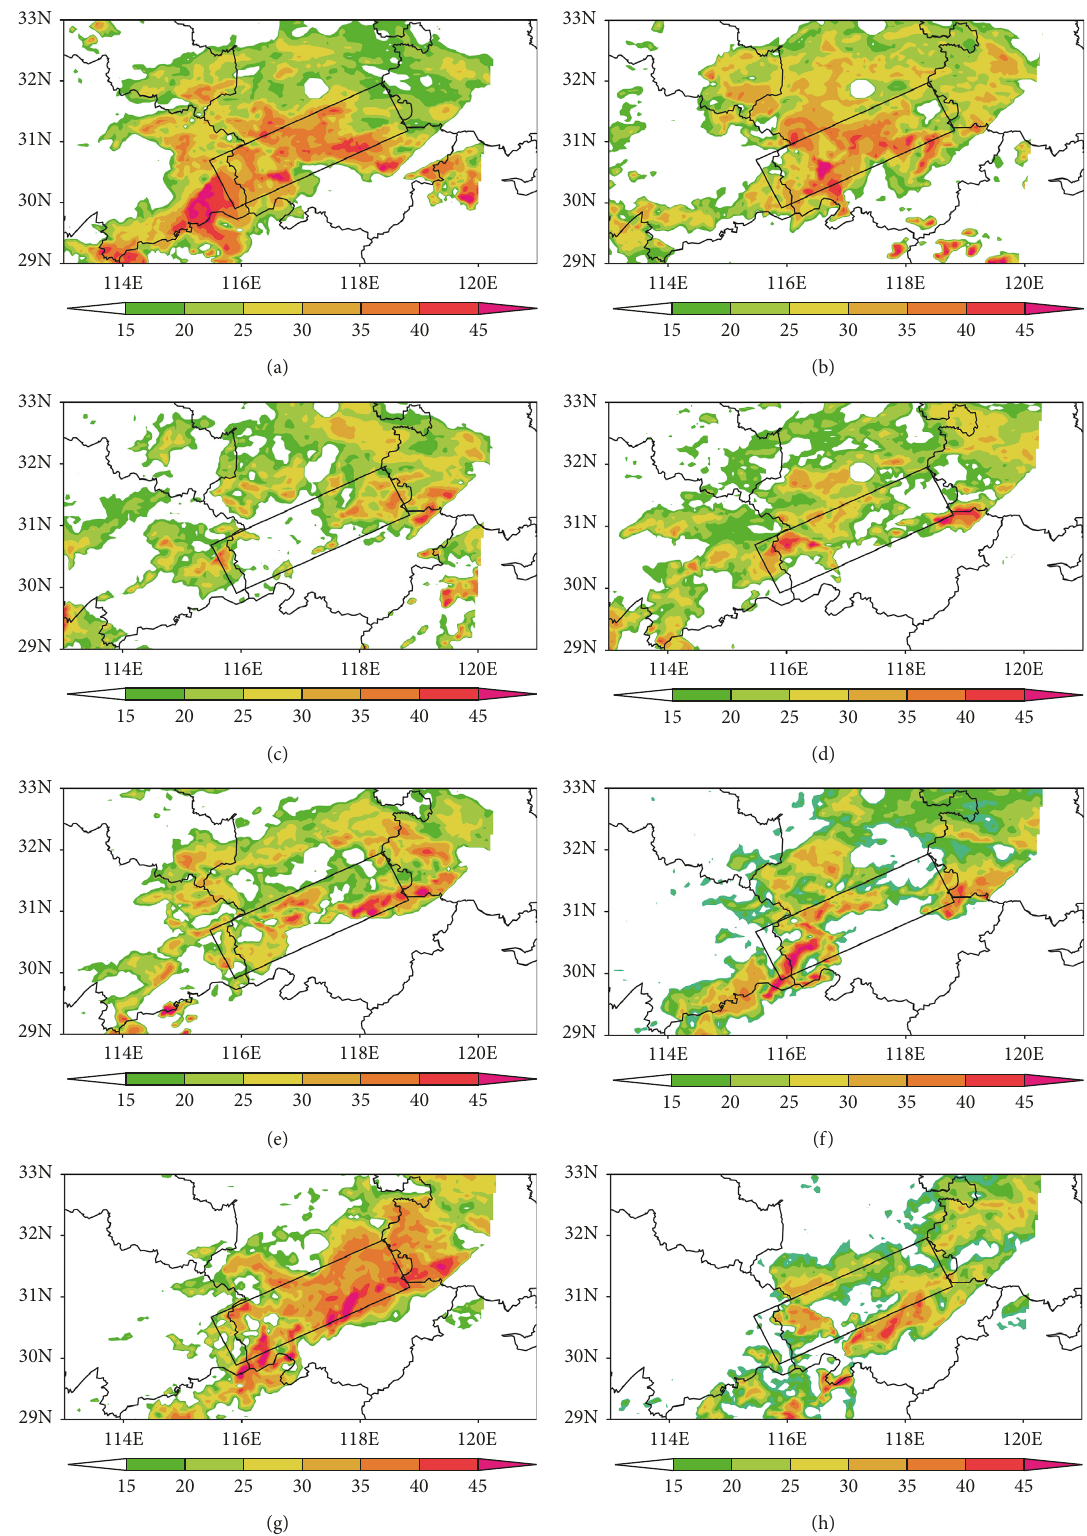
Figure 6: Observed radar echoes at the height of 3km during 0300 UTC 4 July–0000 UTC 5 July at 3-h intervals (a) 0300 UTC 4 July; (b) 0600 UTC 4 July, (c) 0900 UTC 4 July; (d) 1200 UTC 4 July; (e) 1500 UTC 4 July; (f) 1800 UTC 4 July; (g) 2100 UTC 4 July; (h) 0000 UTC 5 July. Unit: dBZ. The black frame indicates the key rainstorm